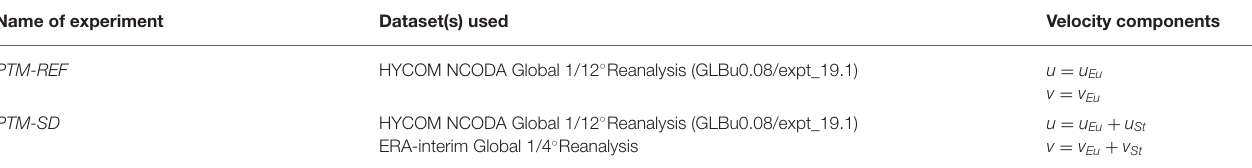
TABLE 1 | Velocity datasets and variables used for the two particle simulations, PTM-REF and PTM-SD